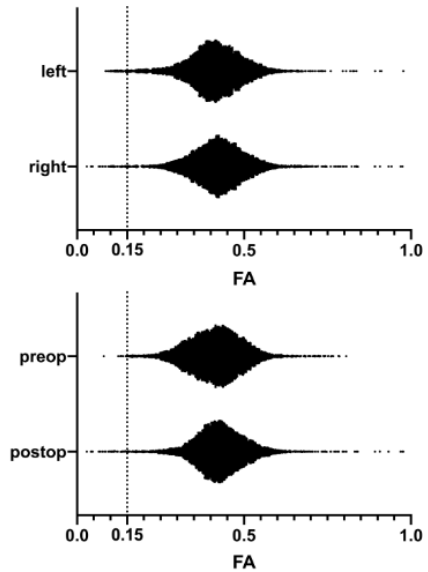
Figure 2. The pooled FA values in the left and right hemisphere (above) and preoperative and postoperative MRI (below). Dotted line: 0.15. There was a statistically significant difference between the CSTs of the left and right hemisphere (median 0.4156 versus 0.4263, p < 0.0001), as well as between the preop and postop FA (median 0.4198 versus 0.4266, p < 0.0001) with the postop FA values being especially less frequent below their mean.